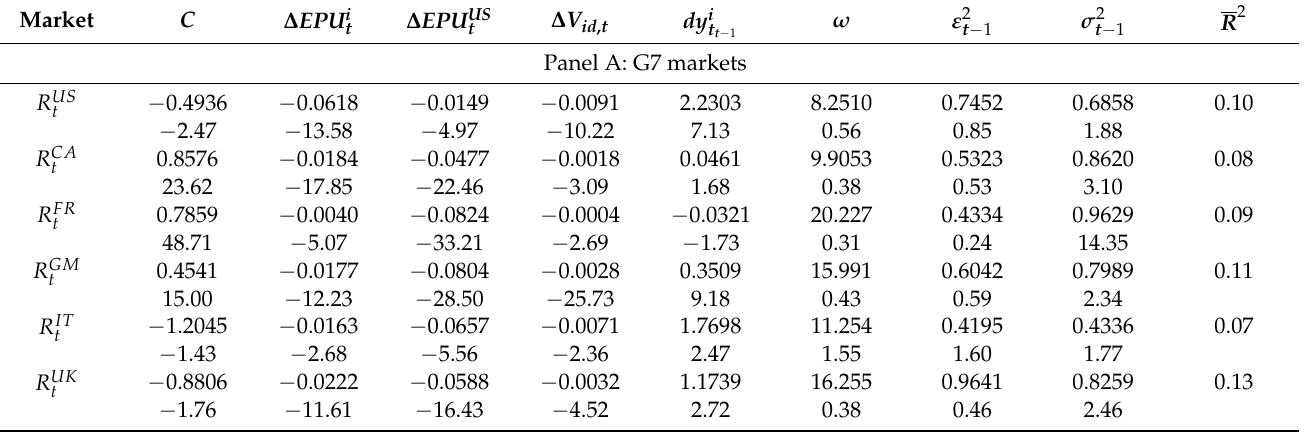
Table 5. Estimates of the global stock returns in response to change in economic policy uncertainty, change in infected decease uncertainty and dividend yield using the GED–GARCH